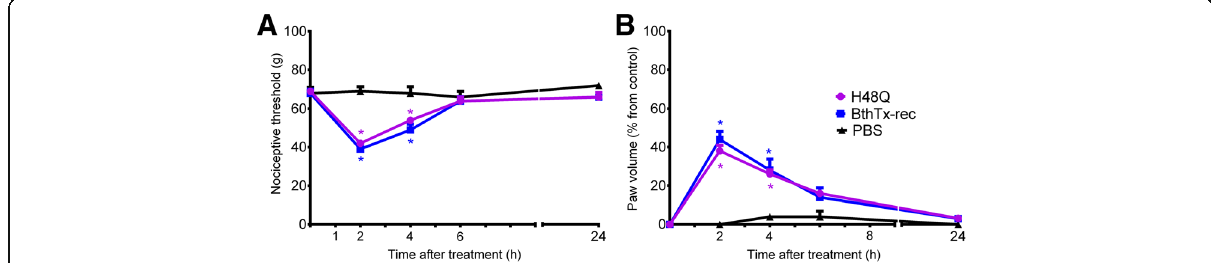
Fig. 5 Effect of H48Q (BthTx-I His48 → Gln) mutagenesis on rat pain threshold and paw volume. Decrease in a threshold response and b paw volume were determined in rat hind paw before and 2, 4, 6 and 24 h after the intraplantar injection of PBS (control group) or H48Q, or recombinant BthTx-I. Sensitivity to pain was measured as the threshold response to pressure and expressed as g . The paw volume was obtained pletsmografically. Each point represents the mean±SEM of six animals. *Significantly different from mean values before venom injection ( p<